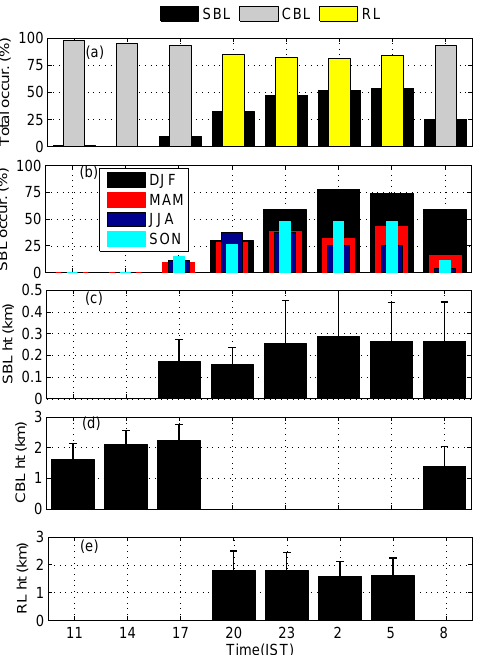
Figure 6. (a) Total percentage occurrence of the SBL, CBL, and RL heights; (b) percentage occurrence of the SBL during different sea- sons. Mean and standard deviations of (c) the SBL height observed at 3h interval between 17:00 and 08:00IST, (d) the CBL observed at 3h interval between 08:00 and 17:00IST, and (e) the RL ob- served at 3h interval between 20:00 and 23:00IST. These statistics are obtained using T variables.